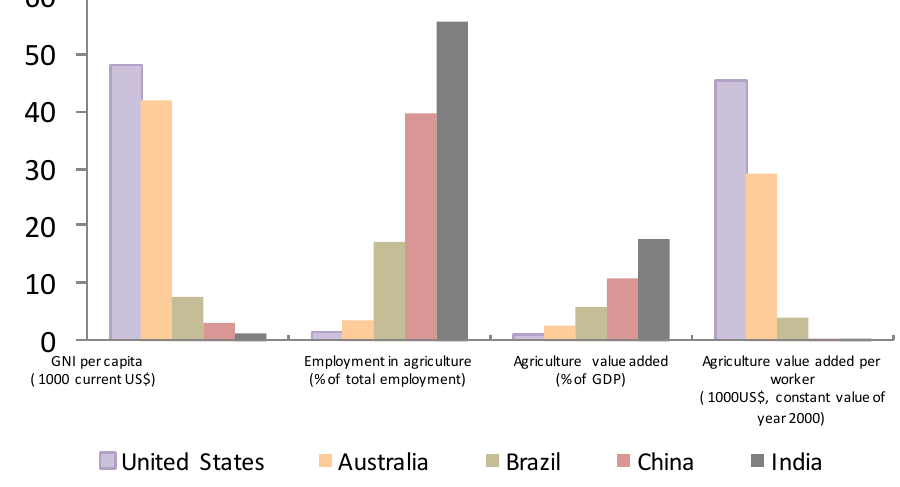
Figure 2. Comparison of structural change and growth among China and selected